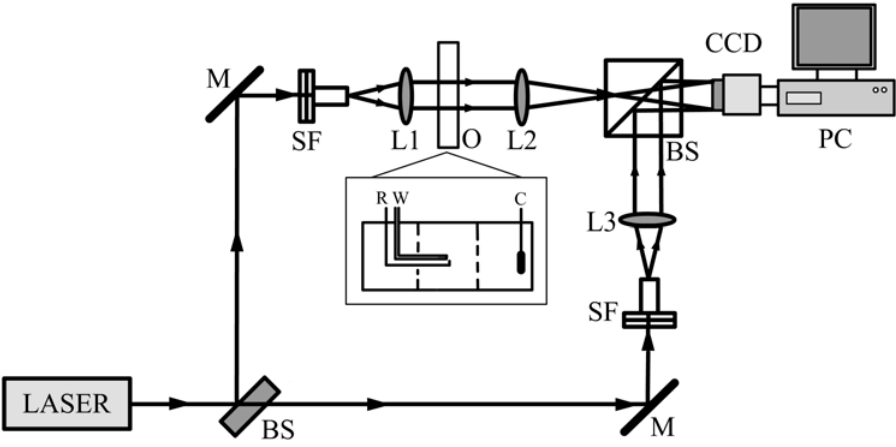
Figure 2. Experimental setup of the Mach-Zehnder interferometer. M, mirror; BS, beam splitter; SF, spatial filter; L1, L2 and L3, lens; O, the electrochemical cell.